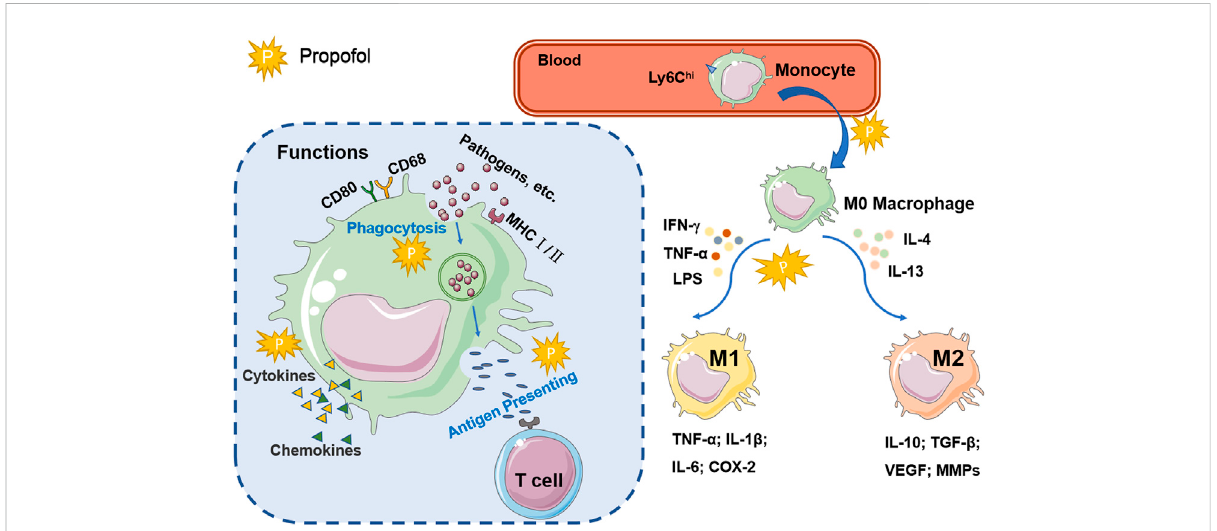
FIGURE 1 The activation and function of macrophages. Ly6C hi monocytes in the blood enter the damaged tissue and differentiate into macrophages. Macrophages recruited by in fl ammation or tumors are stimulated by Th1 or Th2 cytokines to differentiate into two activated types: the classical activated type (M1) and the alternating activated type (M2). Activated macrophages express high levels of CD80, CD68, and MHC I/II. Macrophages phagocytize pathogens and cell fragments, recognize speci fi c antigens, and transmit signals to T cells for antigen presentation. Macrophages participate in immune regulation by regulating the secretion of cytokines and chemokines. The explosion-shaped graphic represents propofol, suggesting that it may be involved in the signaling pathways and cellular processes of